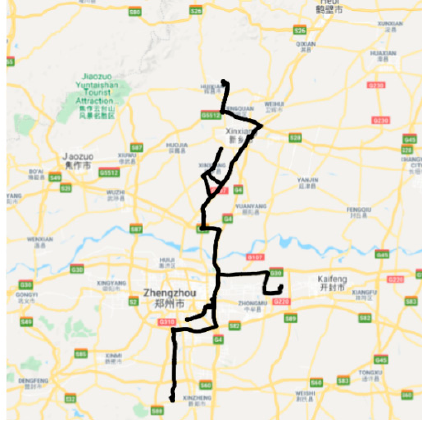
Figure 3. The trajectory of a vehicle in the course of one day.